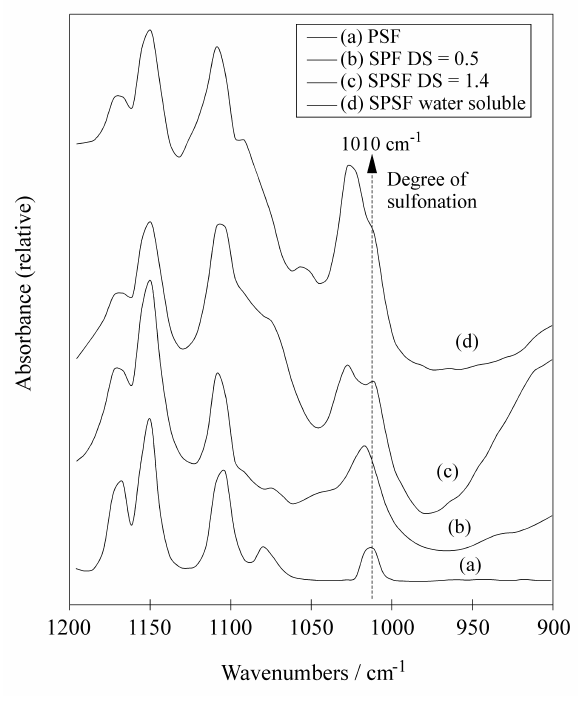
FTIR spectra of sulfonated polysulfones with different degrees of